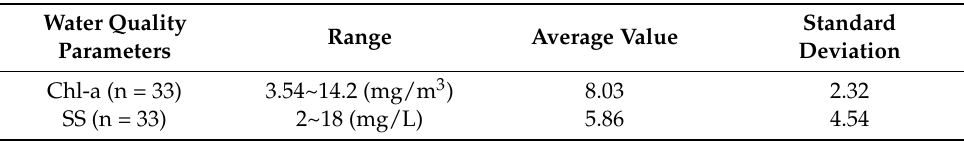
Table 1. Statistical information of the water sampling data in Beigong Reservoir including Chl-a (mg/m 3 ) and SS